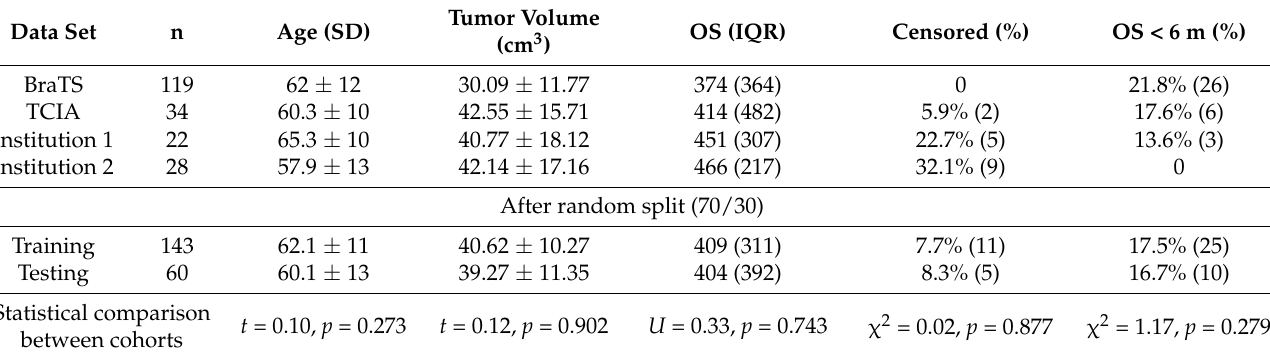
Table 1. Patient